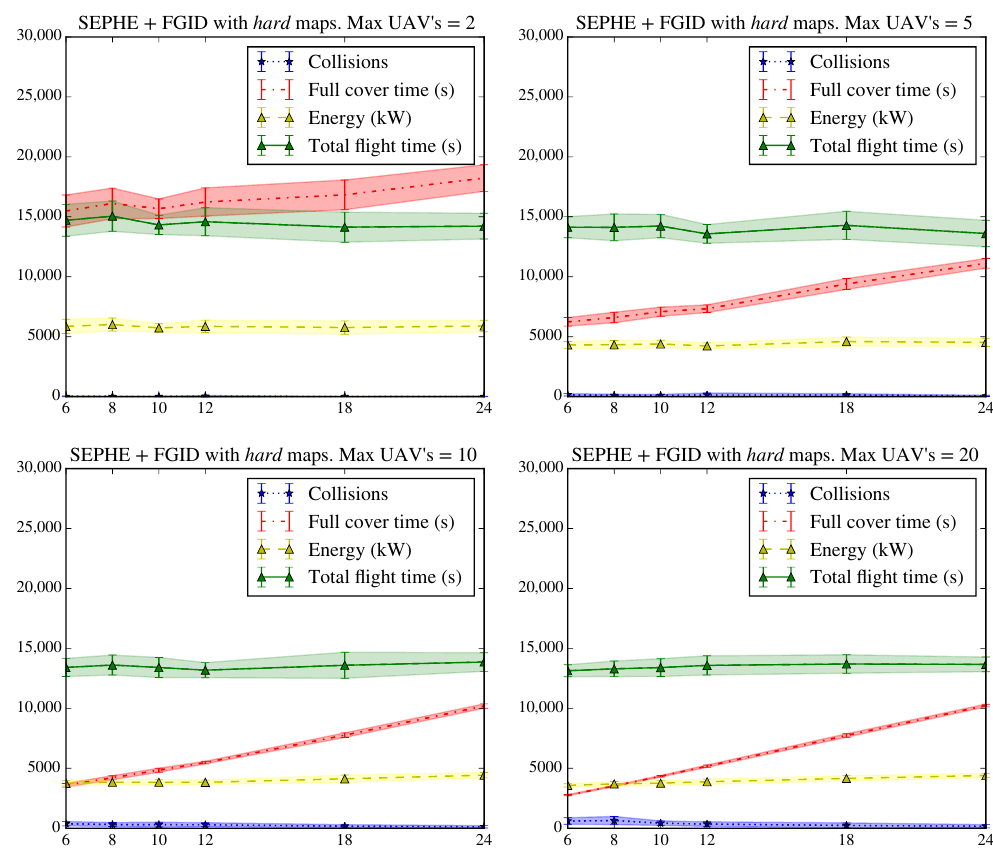
Figure 19. Results of the SEPHE behavior simulations for the FGID take-off strategy in a hard environment. The graph shows the average evolution and variation of the number of collisions, the time required to achieve 95% coverage of the environment, the energy consumed by the swarm, and the total flight time for 600 simulations (50 simulations on the same map for each combination of take-off time interval and maximum number of vehicles in